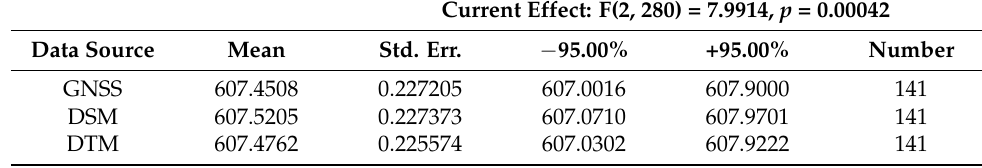
Table 2. Descriptive statistics of the tested elevation points.